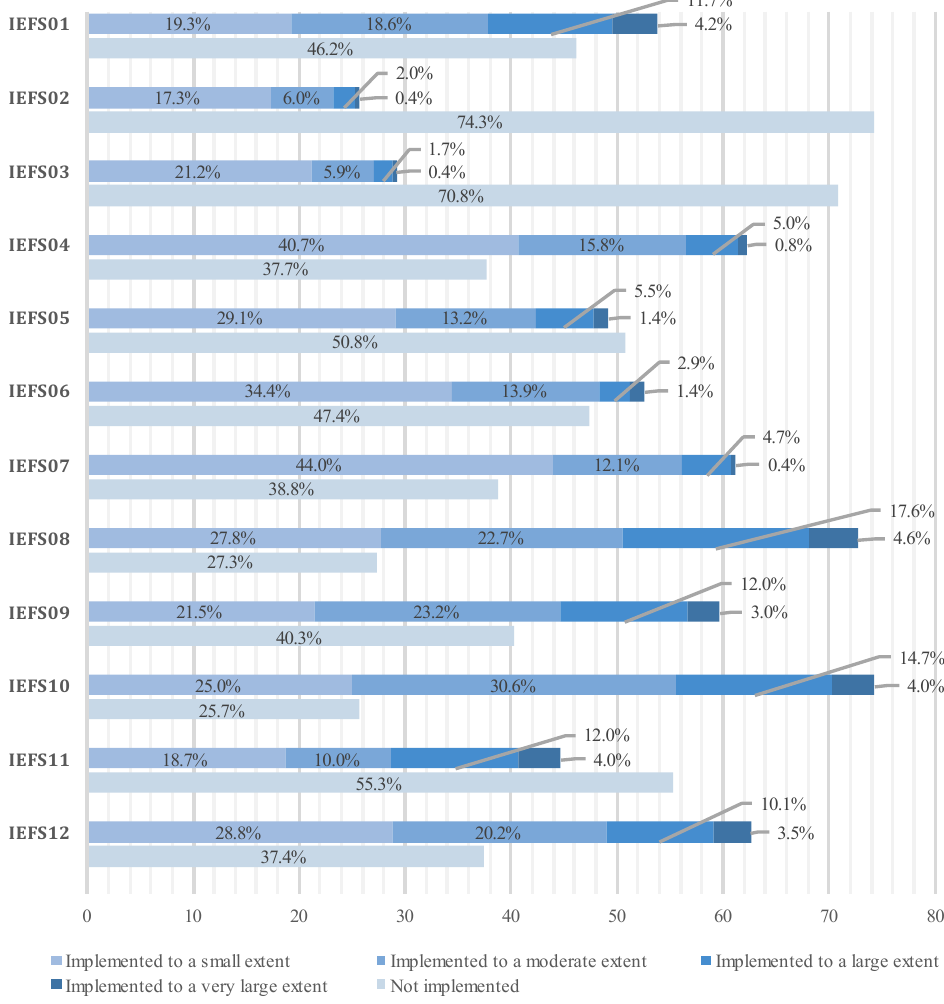
Figure 2. The IEFS implementation level in the surveyed cities.